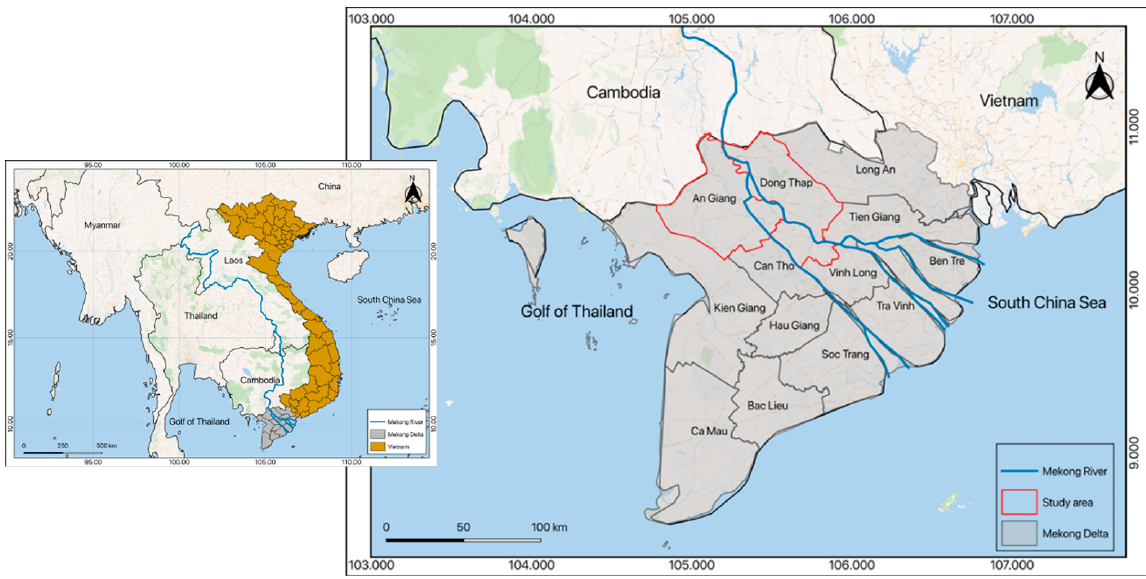
Figure 1. Location of the study site and weather and hydrological stations.